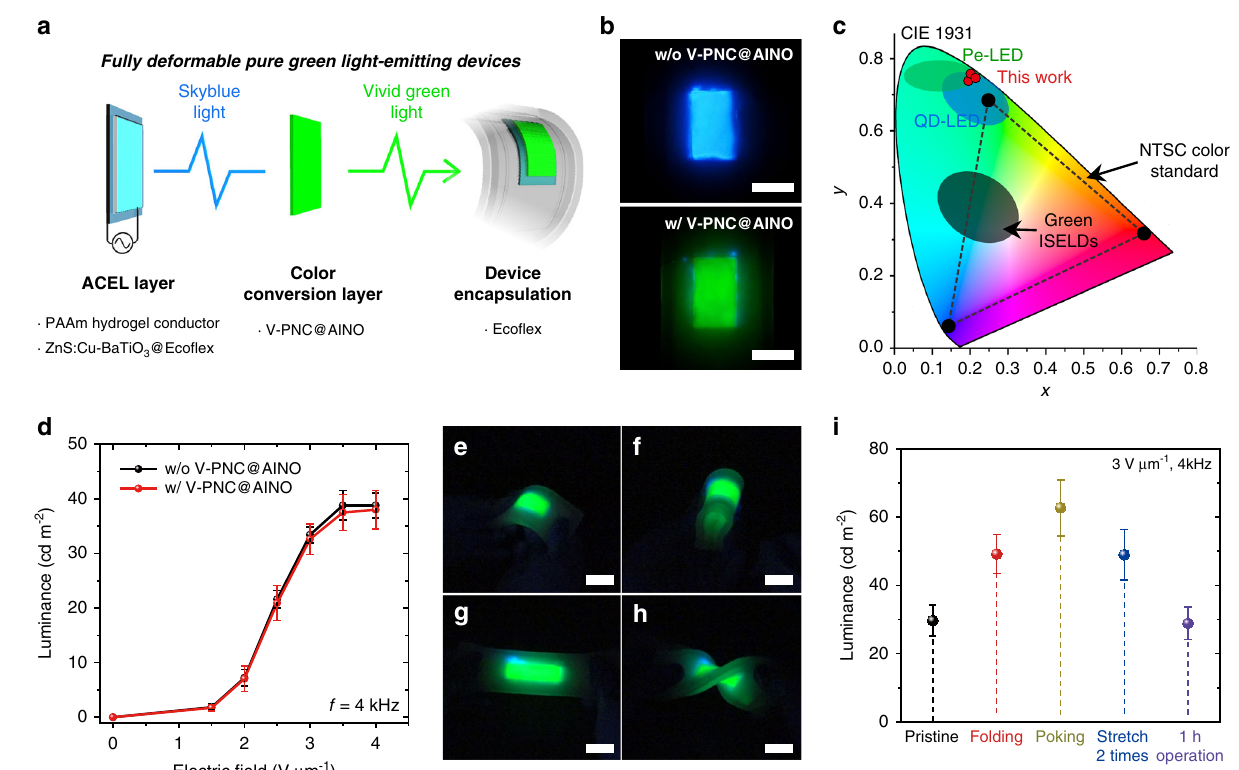
Fig. 5 Demonstration of fully deformable pure green light-emitting devices. a Schematic design of the fully deformable pure green light-emitting device, all of whose components consist of soft materials: stretchable alternate current electroluminescence (ACEL) layer composed of hydrogel ionic conductor and elastomeric electroluminescent nanocomposite, V-PNC@AINO as color conversion layer, and entire device encapsulation with silicone elastomer. ZnS: Cu copper doped zinc sul fi de, BaTiO 3 barium titanate. b Photographs of emission color from the ACEL layer without the V-PNC@AINO layer (upper) and with the layer (lower). Scale bar = 1 cm. c Color coordinates of the devices on the Commission Internationale de l ’ E ́ clairage (CIE) 1931 color space, plotted together with coordinate ranges of existing green quantum dot-based light-emitting diodes (QD-LEDs) or perovskite LEDs (Pe-LEDs), intrinsically stretchable electroluminescent devices (ISELDs), and National Television System Committee (NTSC) color standard. d Luminance of the devices